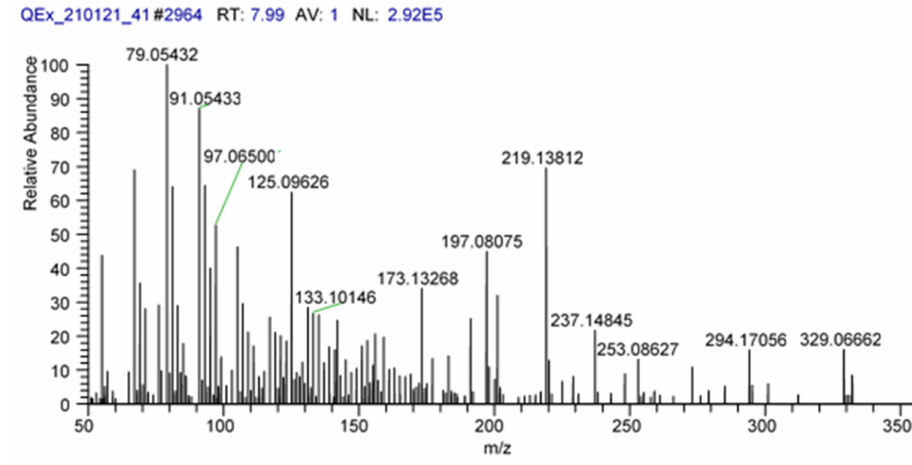
Figure A3. MS/MS spectrum of confirmed AfM 1 metabolite.